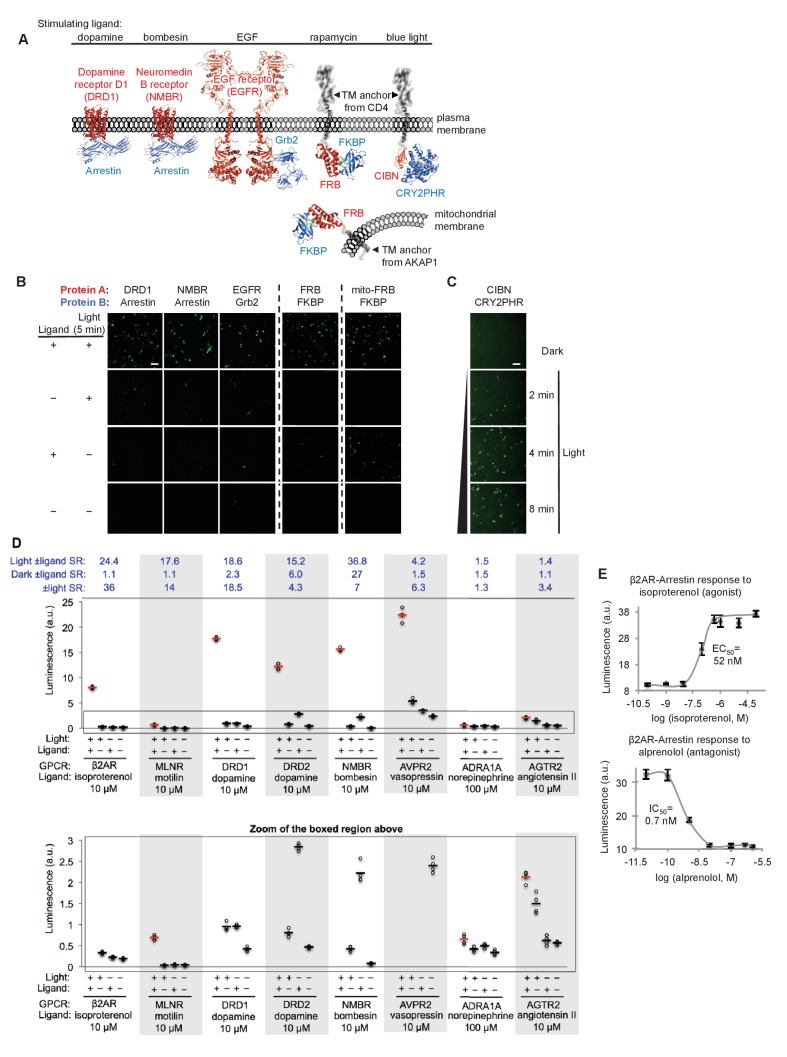
SPARK can be applied to a variety of PPIs.(A) PPI pairs studied with SPARK. DRD1 and NMBR are GPCRs that interact with β-arrestin2. EGFR is a receptor tyrosine kinase that recruits Grb2 upon stimulation with EGF ligand. FKBP and FRB are soluble proteins that heterodimerize upon addition of the drug rapamycin; to keep FRB SPARK out of the nucleus in the basal state, we fuse it to either a plasma membrane anchor (TM from CD4) or a mitochondrial membrane anchor (TM from AKAP1). CIBN-CRY2PHR is a light-inducible PPI (Kennedy et al., 2010). (B) SPARK data corresponding to PPIs depicted in (A). SPARK constructs were the same as those shown in Figure 1B, except β2AR and β-arrestin2 genes were respectively replaced by the A and B protein-coding genes indicated. HEK293T cells transiently expressing SPARK constructs were stimulated with light and the ligand indicated in (A) for 5 min, then fixed and imaged 9 hr later. Citrine fluorescence images are shown. Dashed lines separate experiments that were performed separately and shown with different Citrine intensity scales. Scale bar, 100 μm. Quantitation of EGFR-Grb2 SPARK images (five separate fields of view): ±light signal ratio = 12; ±EGF signal ratio = 27. (C) SPARK detection of CIBN-CRY2PHR interaction. Blue light (467 nm, 60 mW/cm2, 33% duty cycle (2 s light every 6 s)) simultaneously uncages the eLOV domain and induces the CIBN-CRY2PHR interaction. Scale bar, 100 μm. See Figure 2—figure supplement 1 for additional data using FRB-FKBP and CIBN-CRY2PHR SPARK constructs. (D) SPARK applied to eight different GPCRs. HEK293T cells were prepared as in Figure 1D. The SPARK protease component is β-arrestin2-TEVp. The SPARK TF component contains the indicated GPCR (no vasopressin V2 domain). Light (ambient) and ligand were applied for 15 min total, then cells were analyzed for luciferase activity 9 hr later. Four replicates per condition. ±Ligand signal ratios (SR) and ±light signal ratios for each GPCR quantified across top. The boxed region is enlarged at bottom. (E) Isoproterenol and alprenolol dose-response curves with β2AR-β-arrestin2 SPARK readout. HEK293T cells were prepared and stimulated as in Figure 1D, with 5 min light window. Four replicates per concentration. Errors, ±STD. EC50 of 52 nM for isoproterenol and IC50 of 0.7 nM for alprenolol are close to published values (Fisher et al., 2010; Gether et al., 1995).